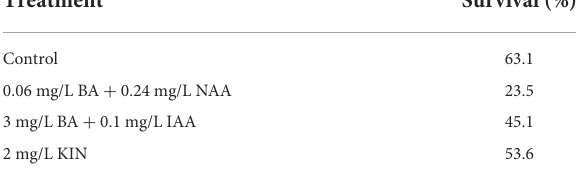
TABLE 4 Percentage of survival of sea knotgrass plants after 30 days of